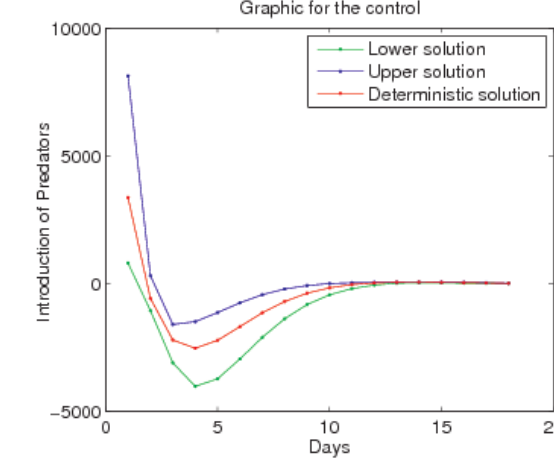
Fig. 6. Introduction of predators for problem